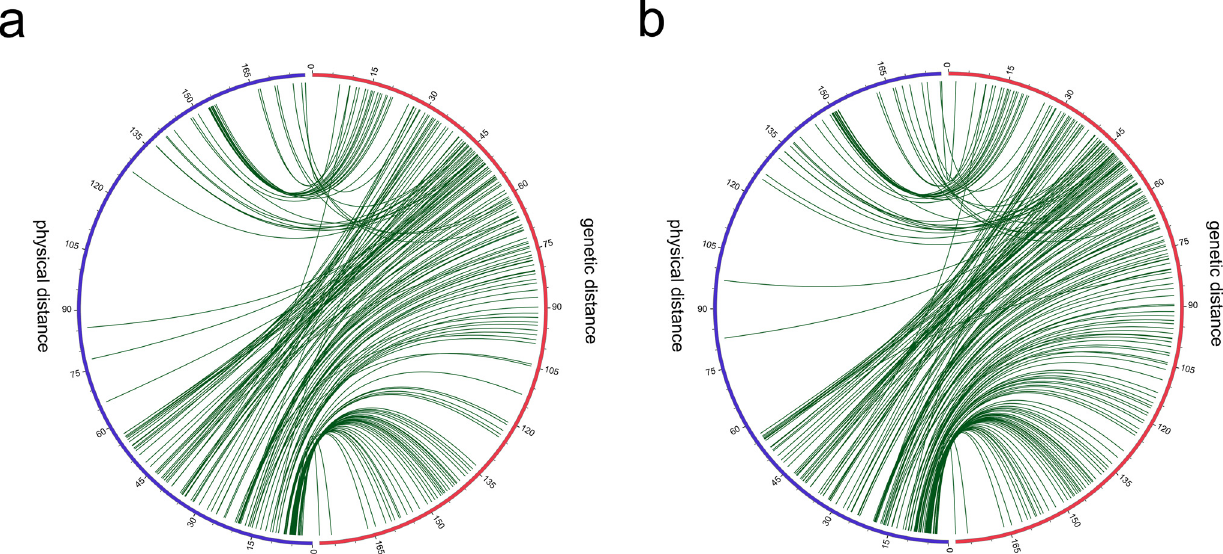
Fig 3. Collinearity of marker positions in the genetic and physical maps using the genome of a: Gossypium hirsutum ; and b: Gossypium raimondii .